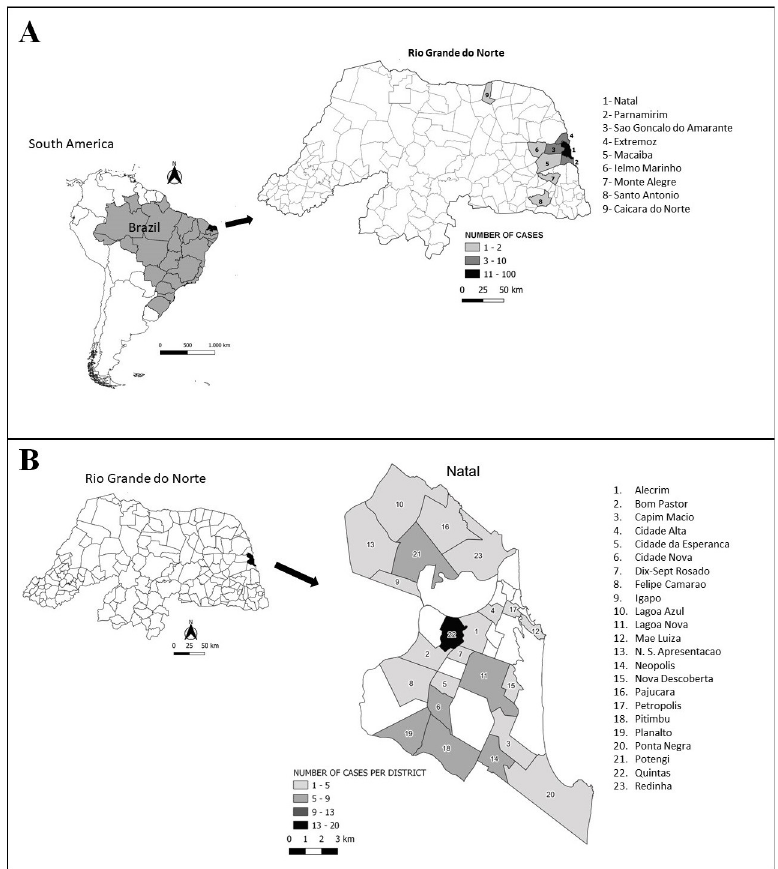
Fig 2. Spatial distribution of cat-transmitted sporotrichosis in Rio Grande do Norte state, Northeast Brazil from October 2016 to December 2019 (A). The most affected area is Quintas district, in the West Zone of the metropolitan region of Natal